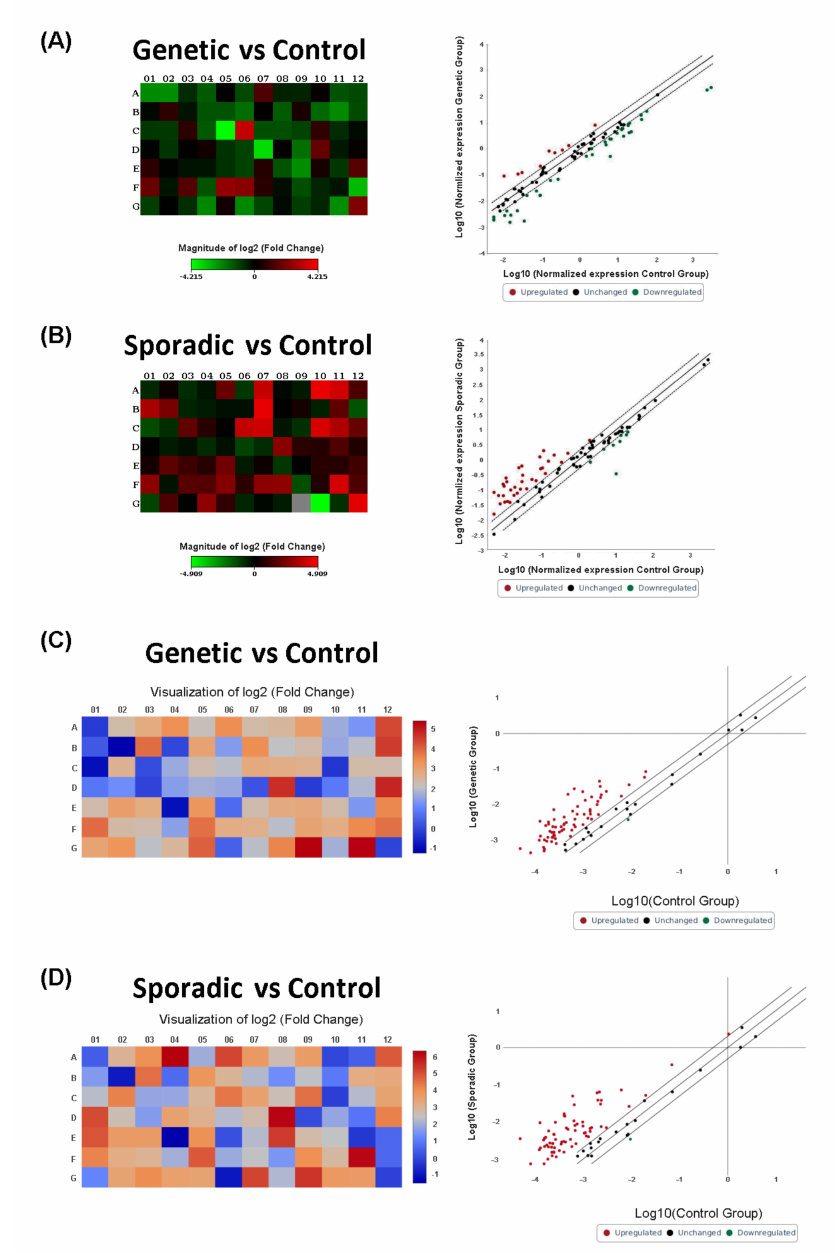
Figure 1. ( A , B ) Heat map and scatter plot of ncRNA profiling for genetic FTD patients and sporadic cases versus control group. Heat Maps: FTD genetic mutations carriers ( A ); sporadic cases ( B ). Data are expressed as fold change (FC). Each square represents one of the 84 miRNAs in the array. Blue indicates downregulation, red upregulation. ( C , D ) Heat Map of the expression fold changes for the 84 lncRNAs array in genetic FTD carriers ( C ); sporadic FTD patients ( D ). Data are expressed as fold change (fold difference). Blue indicates downregulation, red upregulation. Each scatter plot compares the normalized expression of each miRNA on the array between the two selected groups by plotting them against one another to quickly visualize large miRNA expression changes. The central line indicates an unchanged miRNA expres- sion. The dotted lines indicate the selected fold regulation threshold. Data points beyond the dotted lines in the upper left and lower right sections meet the selected fold regulation